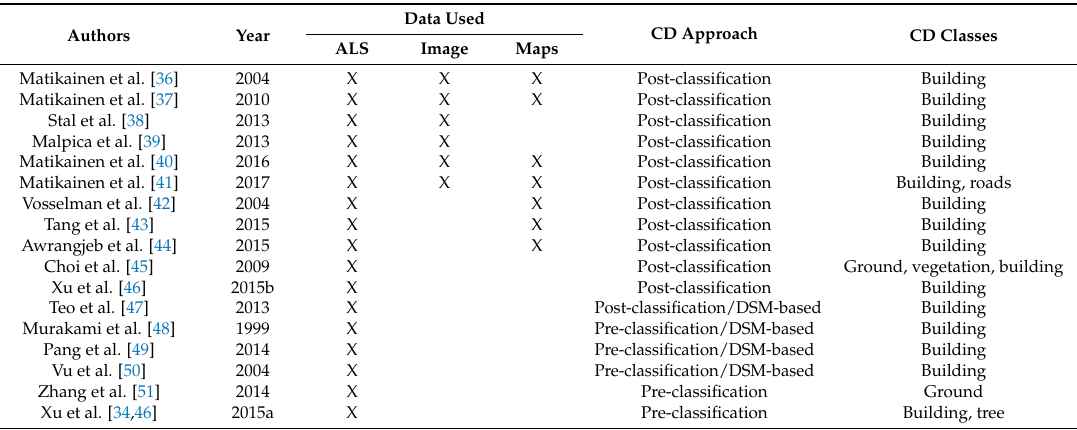
Table 1. List of proposed change detection